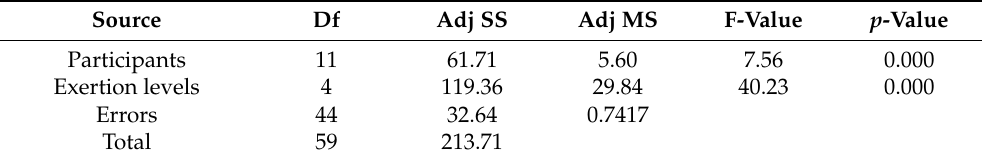
Table 7. ANOVA results for the effect of exertion level on the rate of perceived physical comfort scores. DF: degree of freedom, MS: mean sum of squares, and SS: sum of squares.